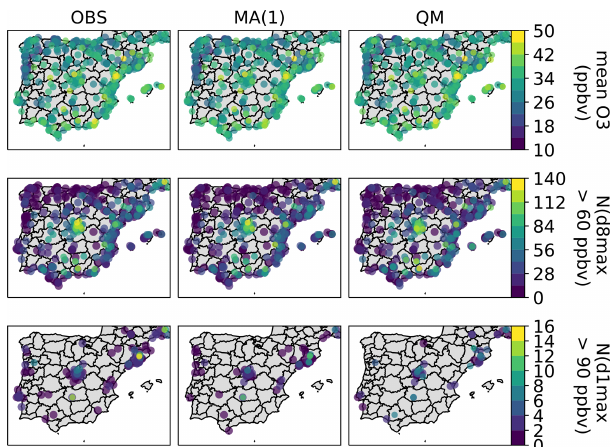
Figure 5. Similar to Fig. 1 but for observations and D + 4 O 3 fore- casts corrected with MA(1) and QM